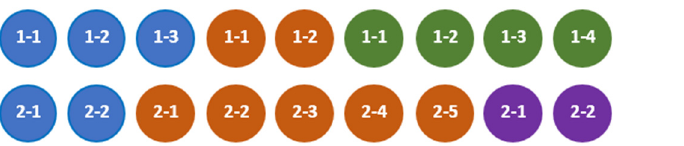
Figure 3. An example of two incompatible aggregates.